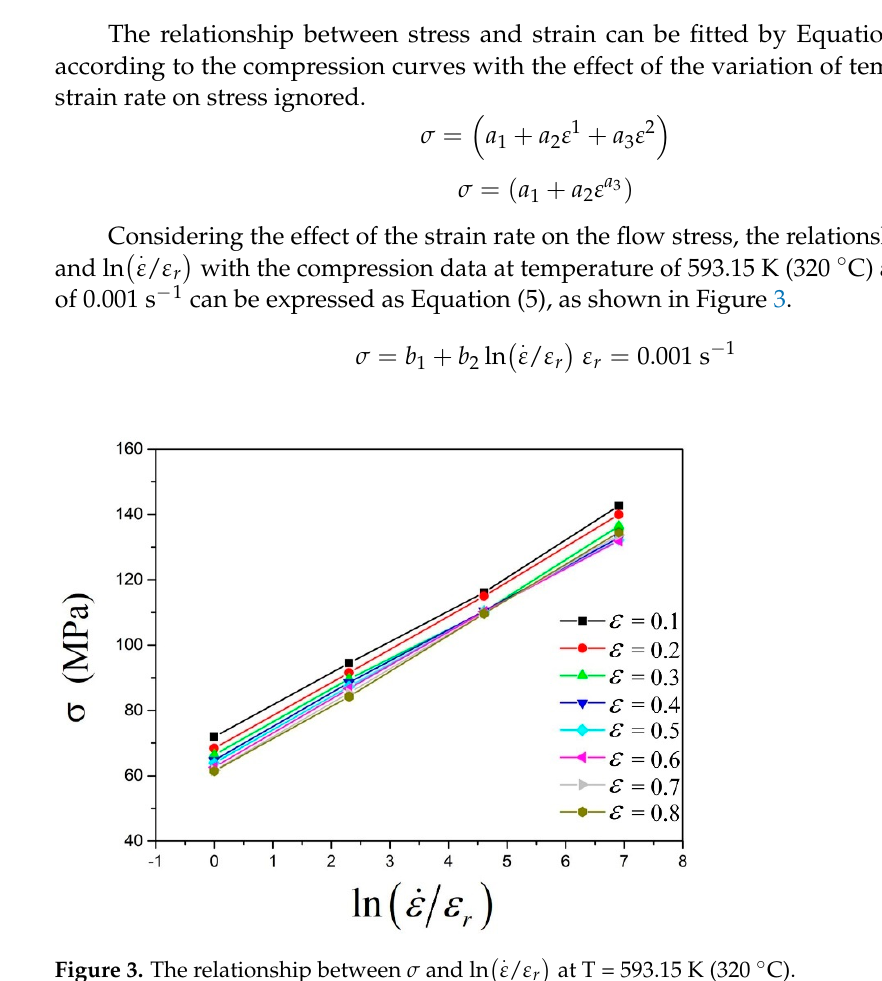
strain rate on stress ignored. according to the compression curves with the effect of the variation of temperature and